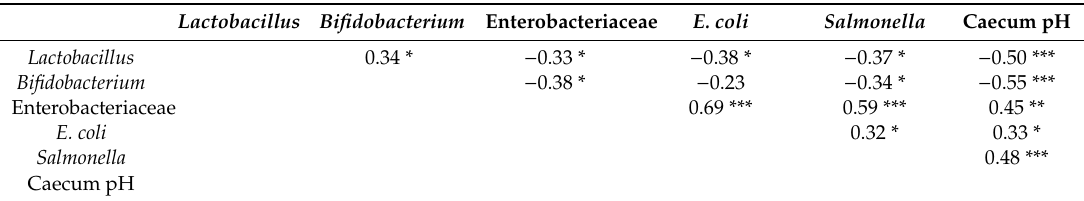
Table 8. Correlation test (R) between measured caecum microbial population and pH in broilers fed postbiotics, ascorbic acid and antibiotic under heat stress.